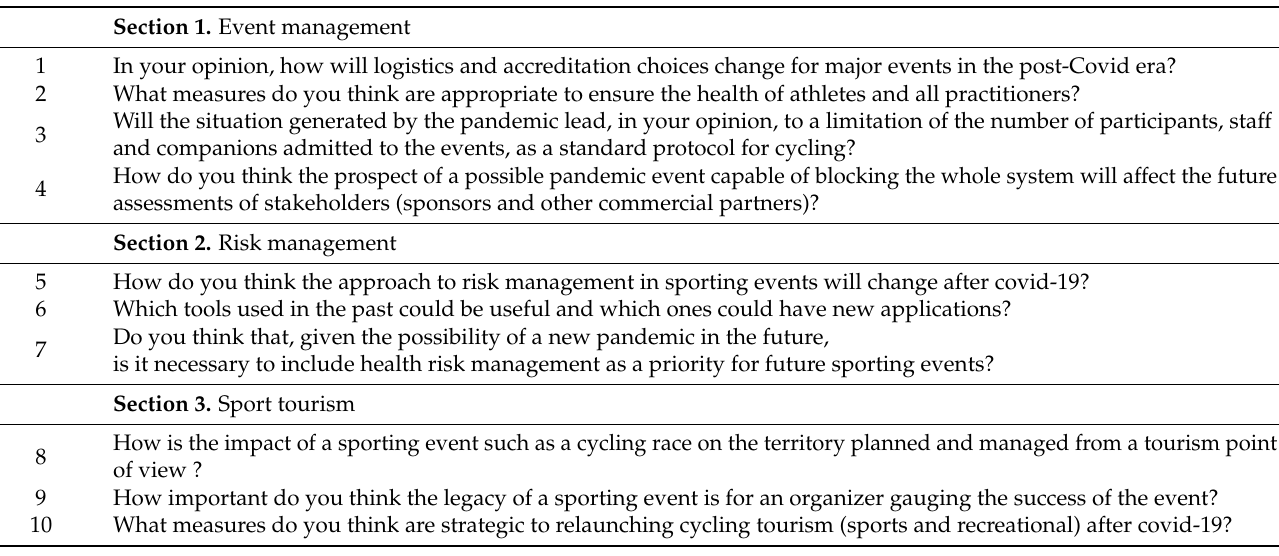
Table A1. Overview of the Interview Guideline.